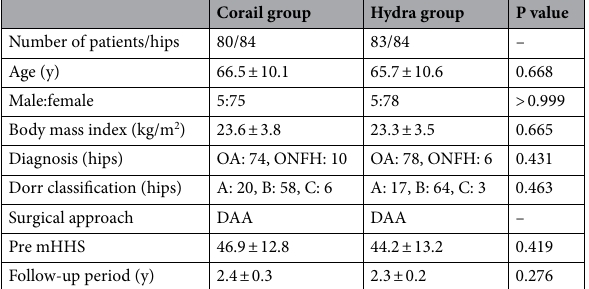
Table 1. Baseline demographics of patients after propensity score matching. OA osteoarthritis, ONFH osteonecrosis of the femoral head, DAA direct anterior approach, mHHS modified Harris hip